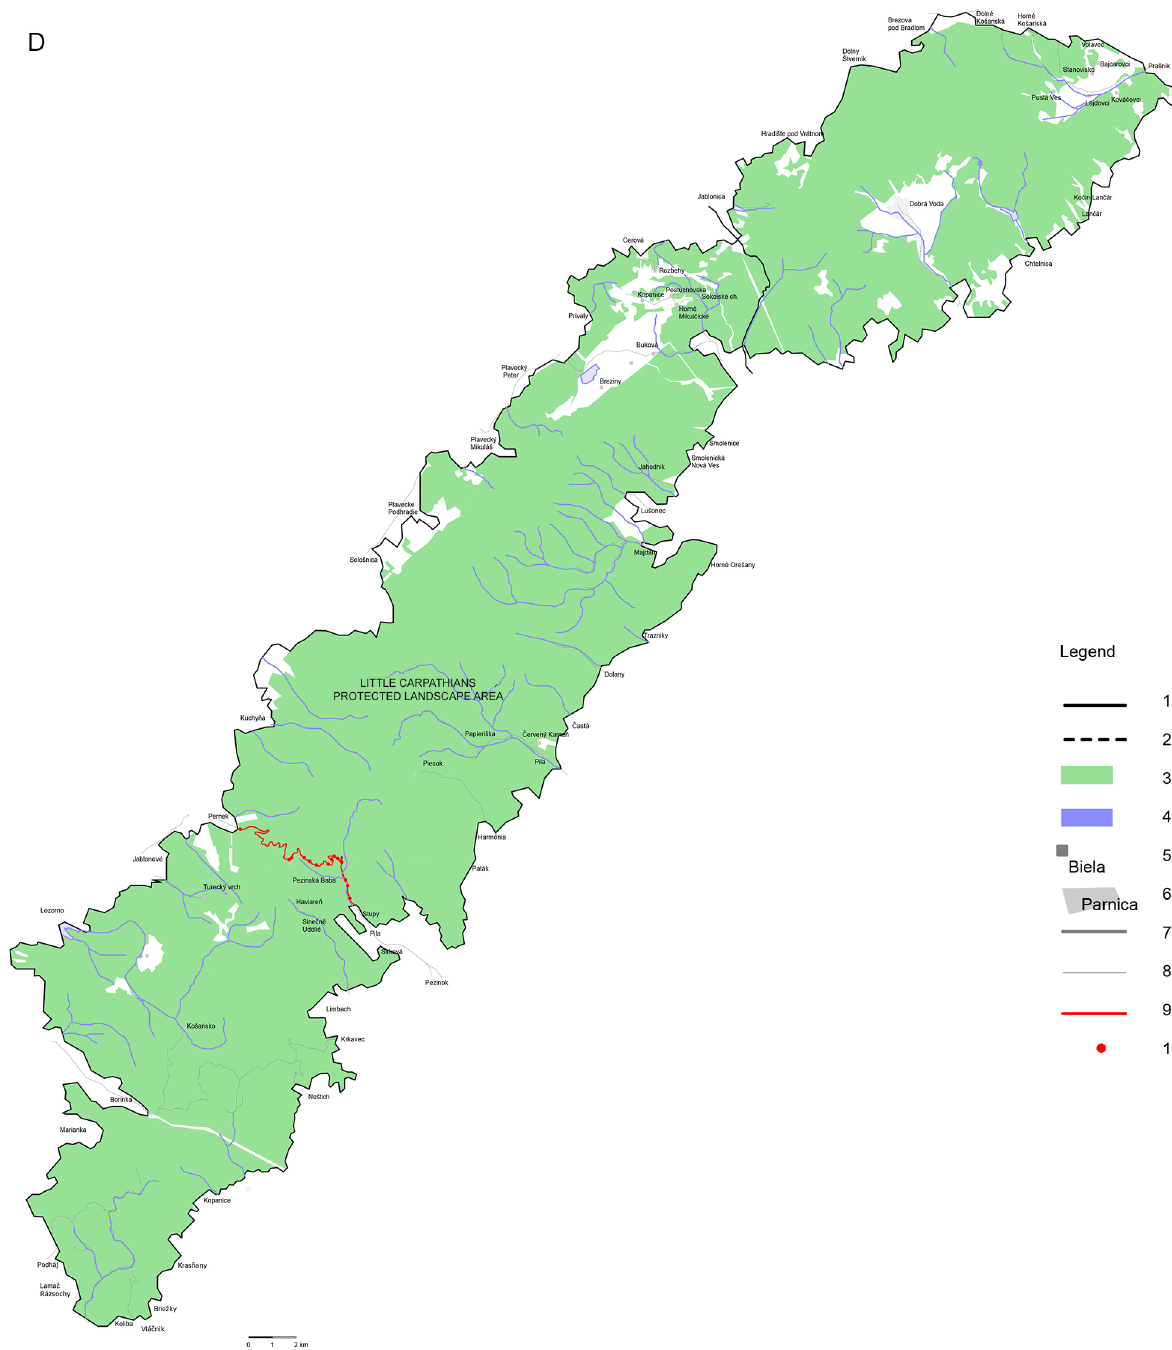
Fig. 2D. Location of advertisements along main roads in the analysed parks: D – Little Carpathians Protected Landscape Area (CHKOMK). 1 – park area border; 2 – buffer zone border; 3 – forests; 4 – water bodies; 5 – villages; 6 – built-up areas; 7 – main road; 8 – secondary road; 9 – road covered by research; 10 – approximate location of advertisements’ aggregations Source: own